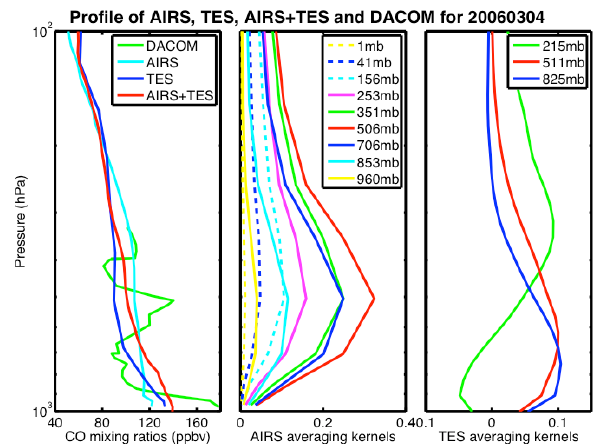
Fig. 9. A profile validation against the DACOM in situ CO measurements on 4 March 2006 (left hand panel) with DACOM CO (green curve), AIRS CO (cyan line), TES CO (blue line), and combined, analyzed CO (red line). Middle panel shows AIRS AKs and right hand panel shows TES AKs.